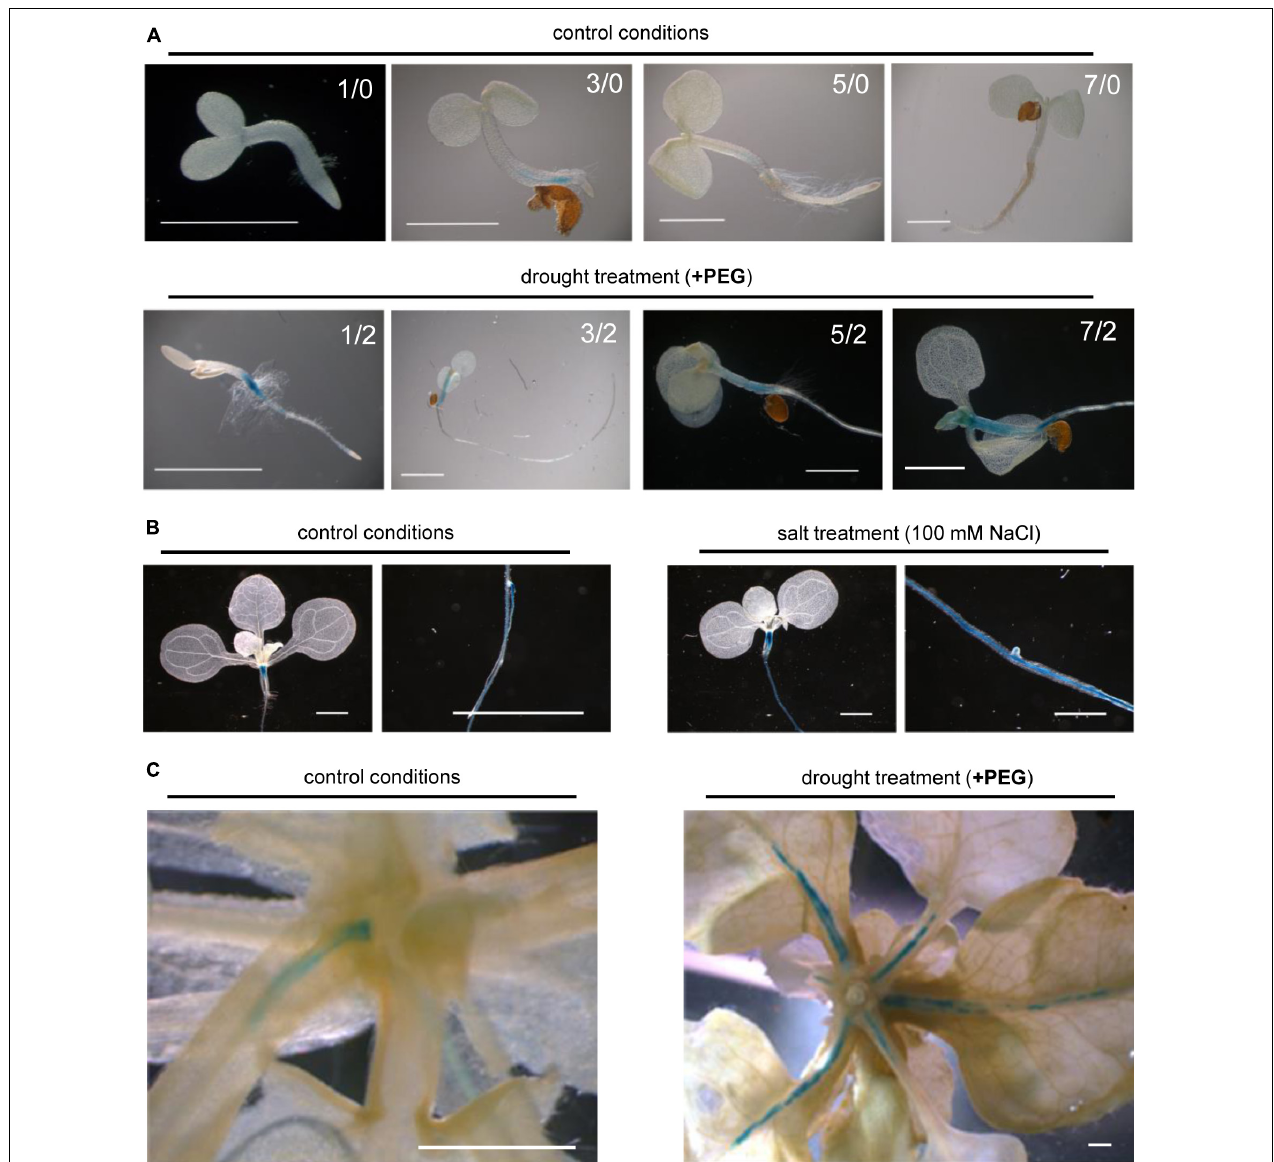
FIGURE 2 | Histochemical staining of proCTPS4: GUS seedlings treated with drought or salt stress. (A) proCTPS4: GUS staining of plants grown on 1/2 MS medium with or without PEG6000 supplementation to induce drought stress (days grown before/after the onset of stress). (B) proCTPS4: GUS staining of plants on MS agar for 12 days with subsequent transfer to plates supplemented with 100 mM NaCl for another 2 days to induce salt stress. (C) proCTPS4: GUS staining of 26-day-old plants grown in hydroponic culture before transfer to PEG 6000 containing medium for another 5 days. Scale bar = 1